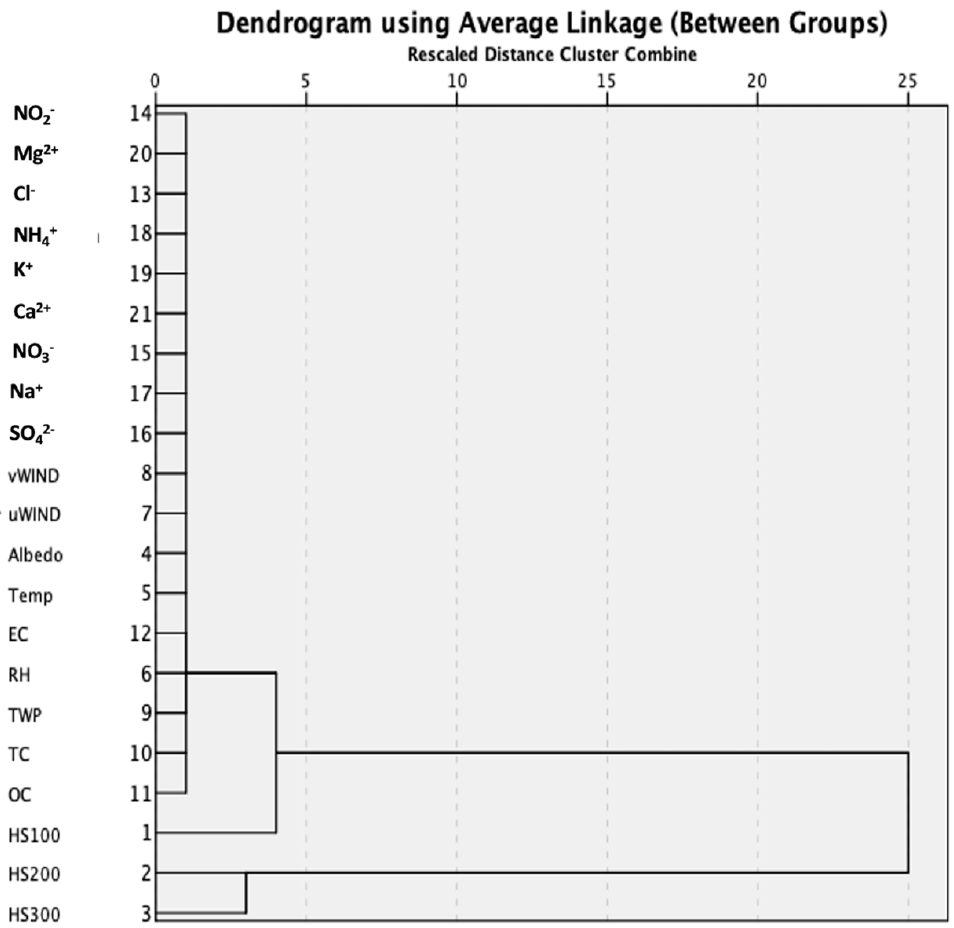
Figure 4. A dendrogram of hierarchical cluster analysis using meteorological parameters: WSIS, OC , and EC in PM 2.5 collected at COS, BOS, and POS.